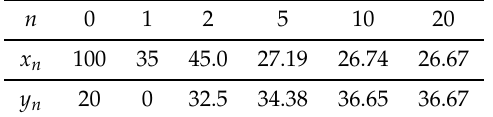
Table 5. Values of the iterated sequence ( x n , y n ) if started with ( 100,20 ) .